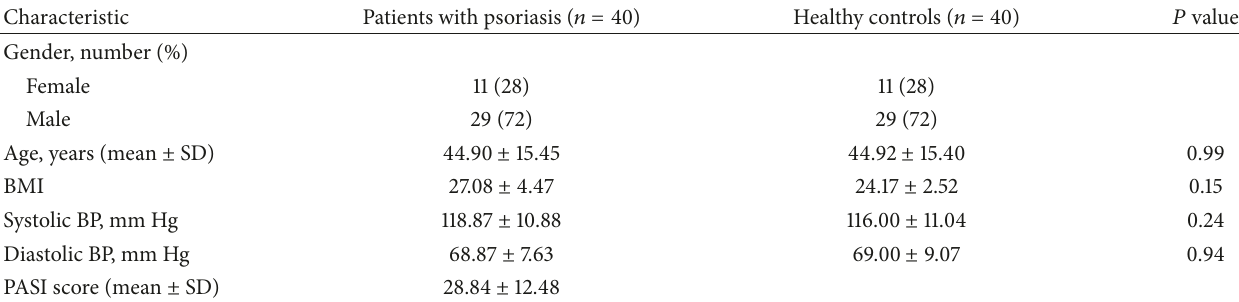
Table 1: Demographics and clinical features of patients with psoriasis and healthy controls.